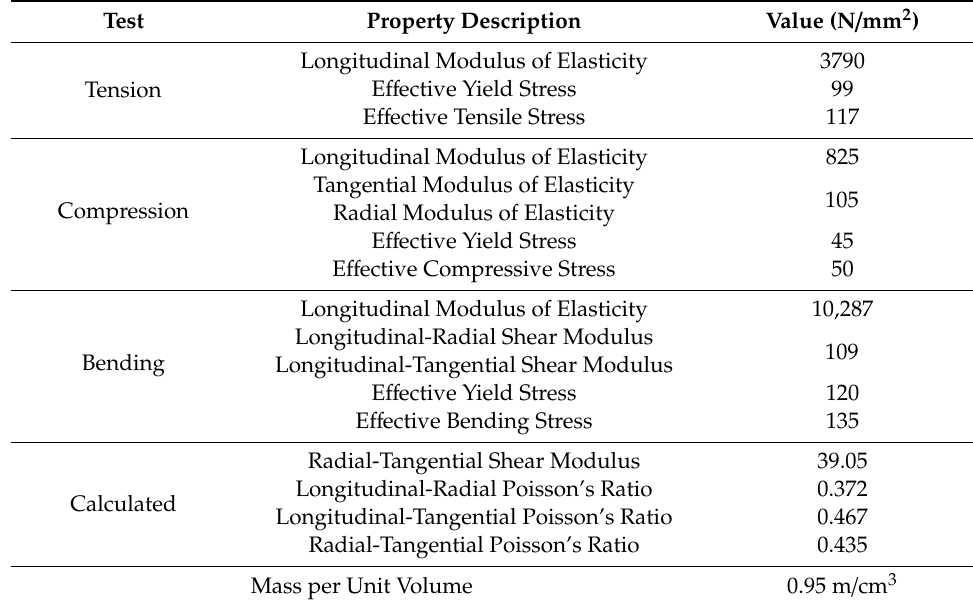
Table 2. Mechanical properties of date palm midribs (Baladi species-soft cultivar) according to EN408–2003 (Moisture Content = 10%)